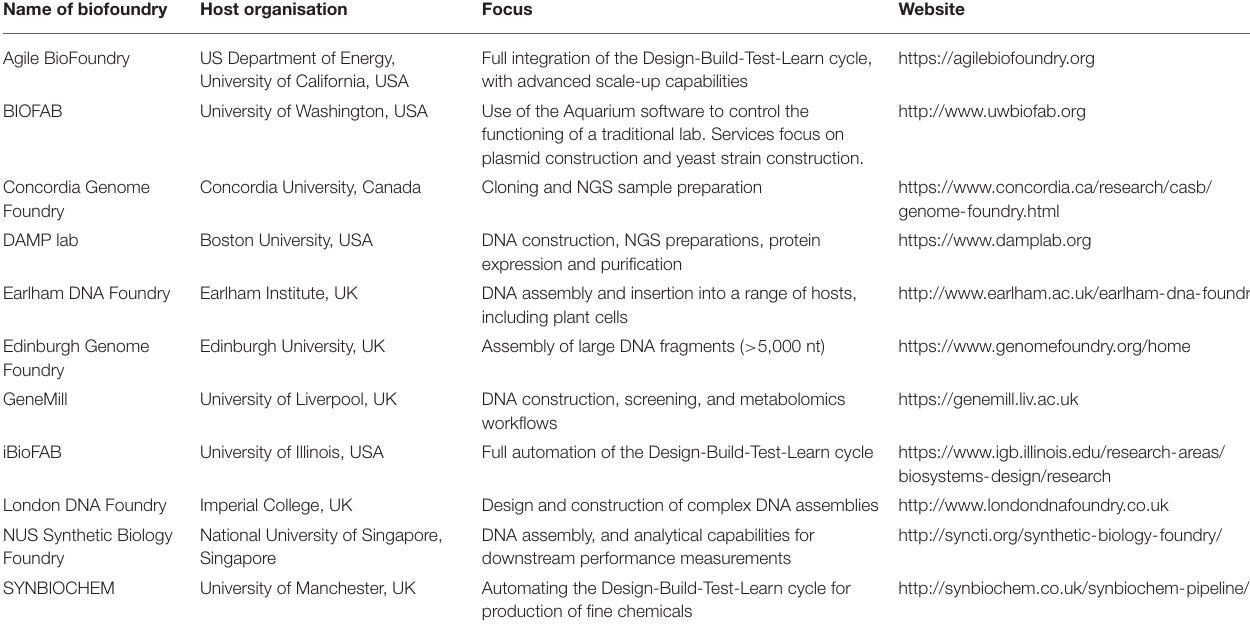
TABLE 1 | Overview of Biofoundries based at public institutions around the